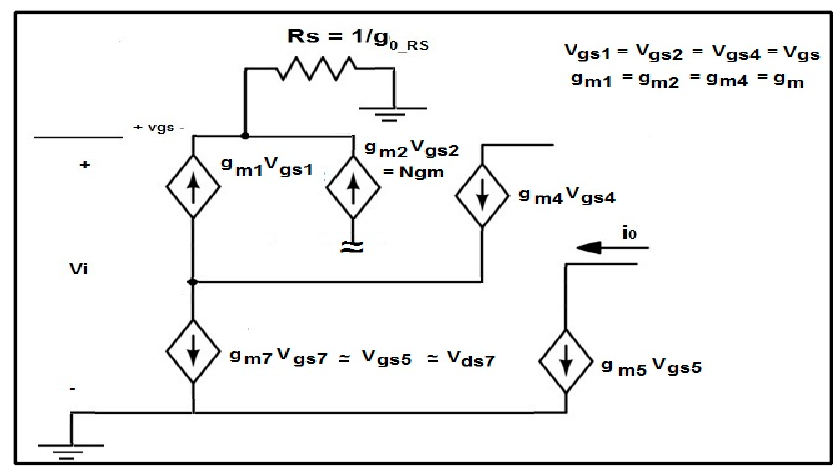
Figure 8. Small signal model of the half circuit.